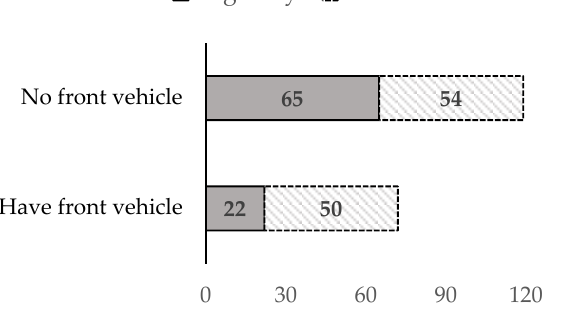
Figure 7. Numbers of videos.